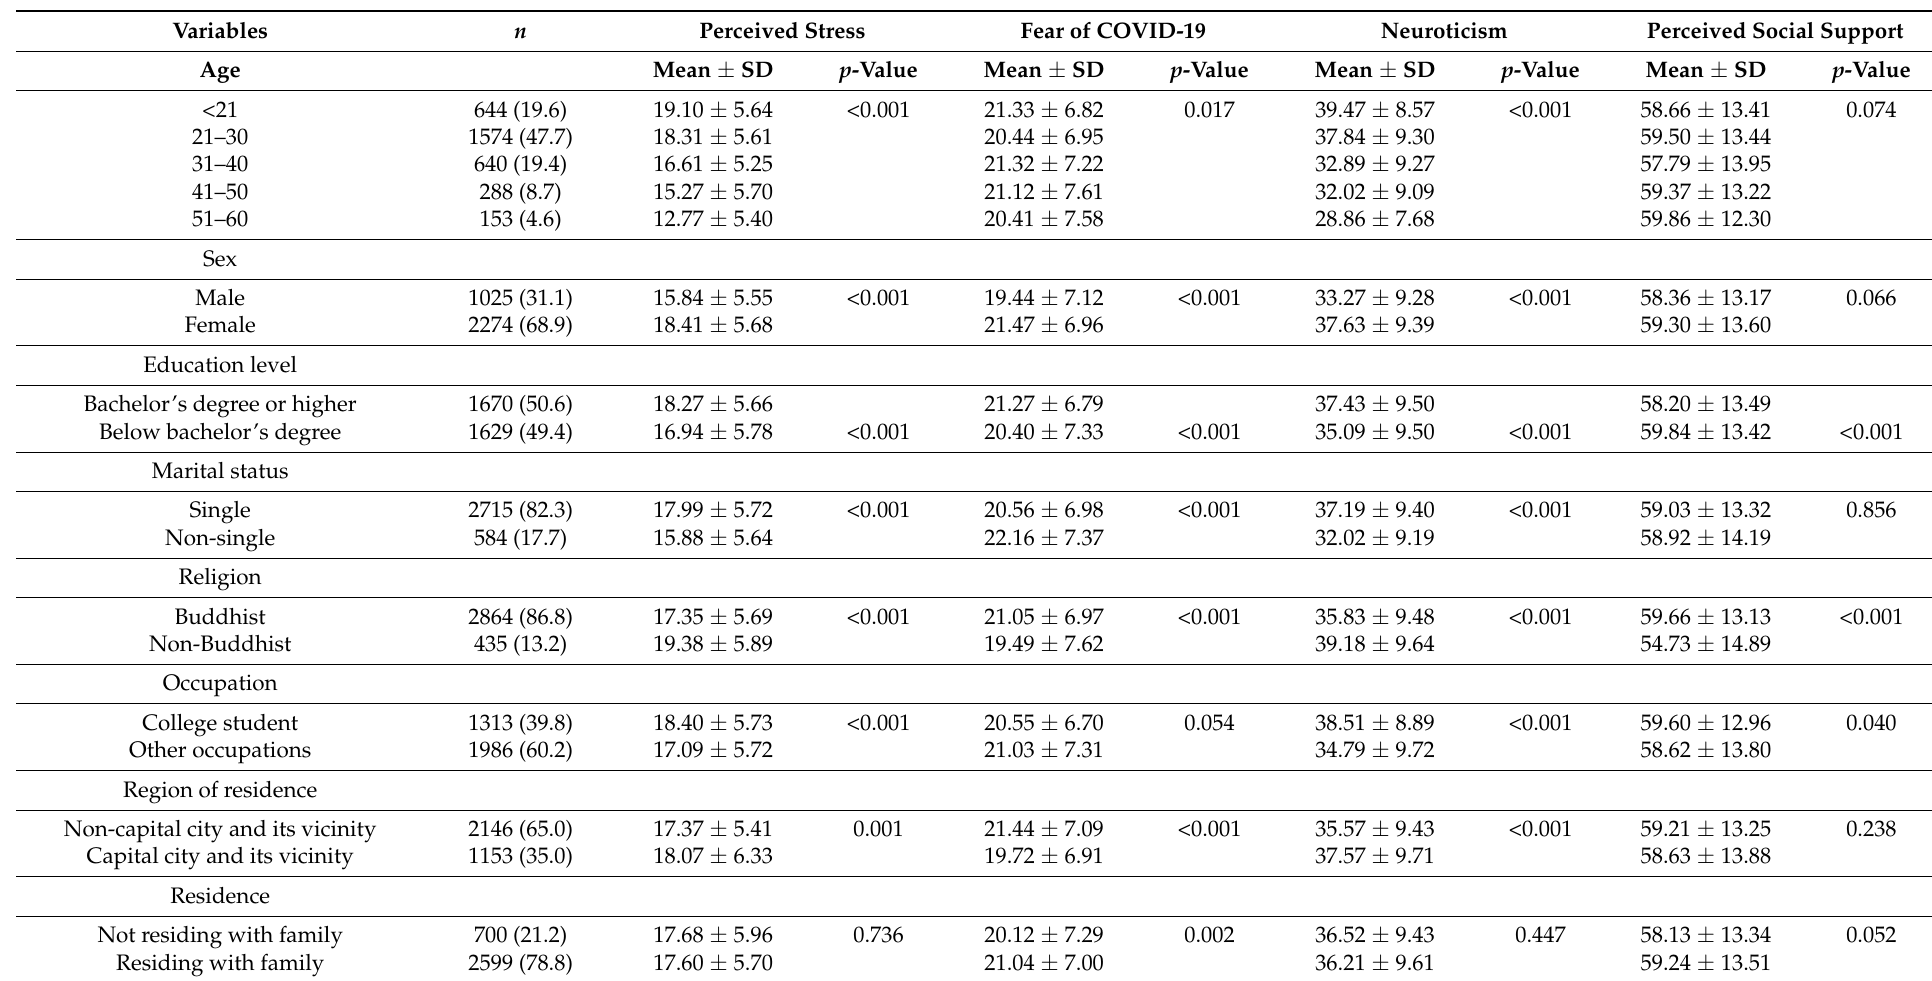
Table 2. Mean and SD of psychological variables in participant characteristics (N =